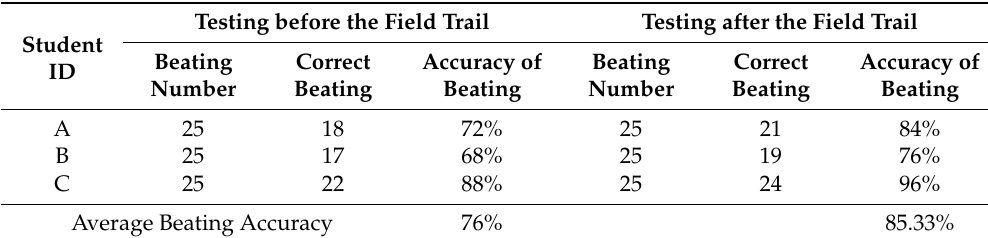
Table 4. Testing results of three